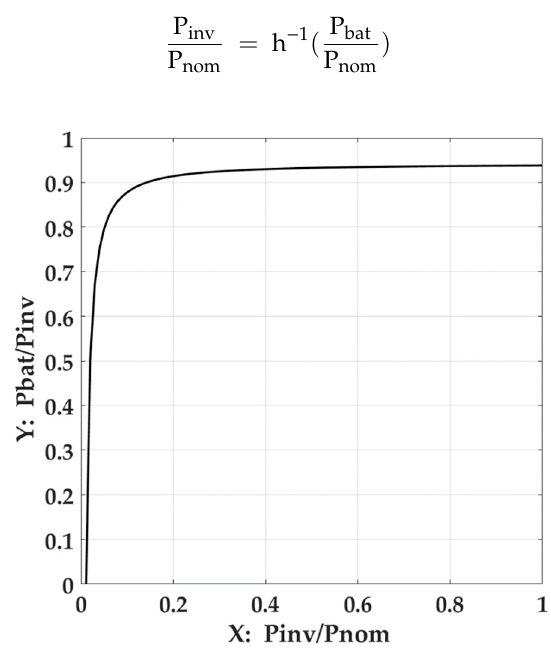
Figure 3. DC/AC efficiency, Y = f(x). Figure 3. DC / AC e ffi ciency, Y =